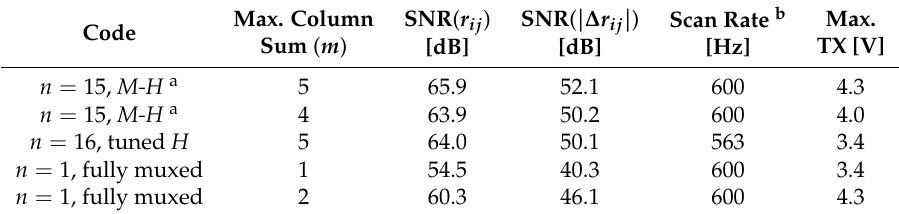
Table 2. Comparative results for a full scan of 15 TX